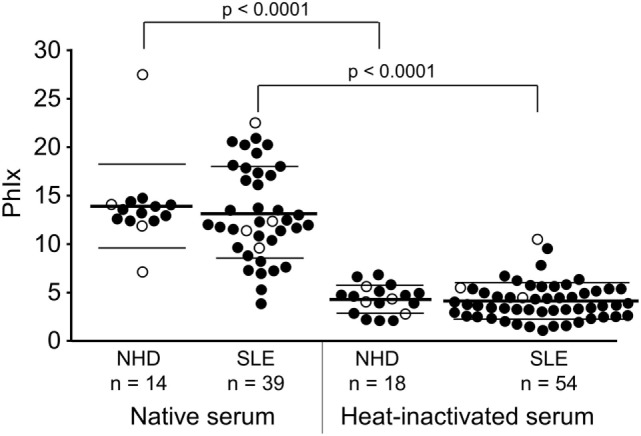
Influence of heat-labile serum components on the phagocytosis of necrotic cells by human monocyte-derived macrophages. Uptake of necrotic cells was analyzed by flow cytometry and quantified by the phagocytosis index (PhIx). Phagocytosis was allowed in the presence of native or heat-inactivated (56°C for 30 min) serum from normal healthy donors (NHD) or patients with systemic lupus erythematosus (SLE). Phagocytosis in heat-inactivated serum was lower in both cohorts than in native serum (NHD and SLE each p < 0.0001). There was no significant difference in phagocytosis between the NHD and SLE cohort neither in native serum nor in heat-inactivated serum. Open symbols (only PhIx available), filled symbols (PhIx and lysophosphatidylcholine concentration available), bold bars (cohort means), thin bars (cohort SDs).